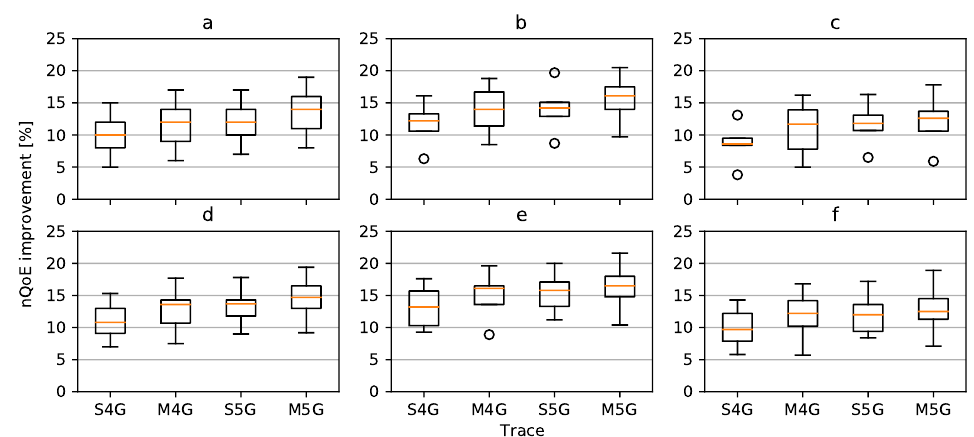
Figure 13. The relative improvement of the nQoE metric across different HAS algorithms and network traces with respect to the no-prediction: ( a ) MSS, LSTM, ( b ) ExoPlayer, LSTM, ( c ) Tian, LSTM, ( d ) MSS, BdLSTM, ( e ) ExoPlayer, BdLSTM, and ( f ) Tian, BdLSTM. The nQoE metrics are normalized to the no-prediction case set to 0% improvement. The scenarios with traces from the mobile environment obtain, on average, better results, but their variation is also